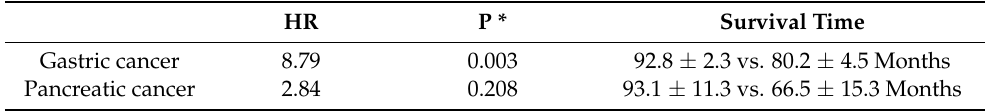
Table 1. ALCAM and patient’s peritoneal metastasis-free survival in gastric and pancreatic